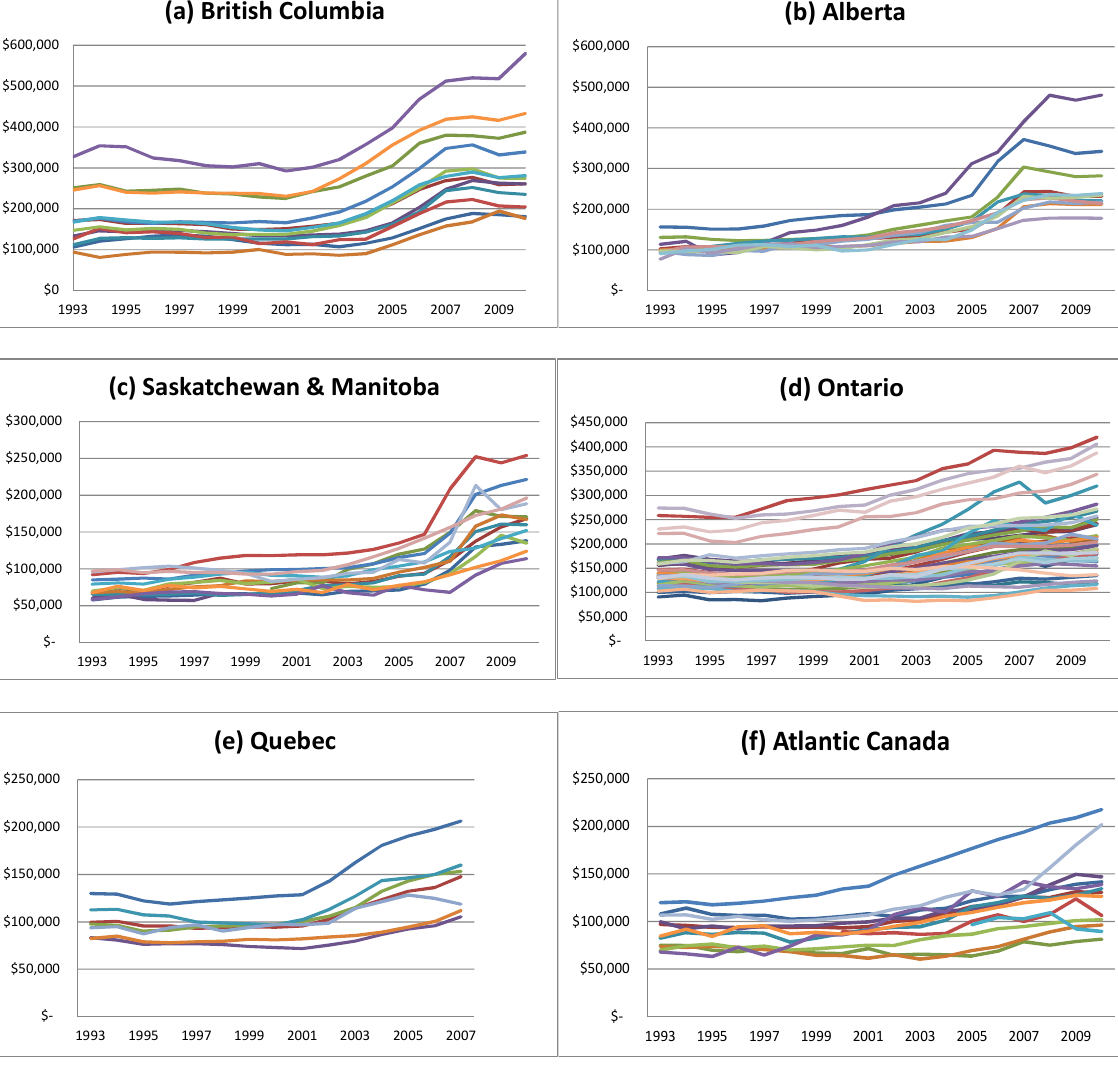
Figure 2 : Real average housing price by Real Estate Board,